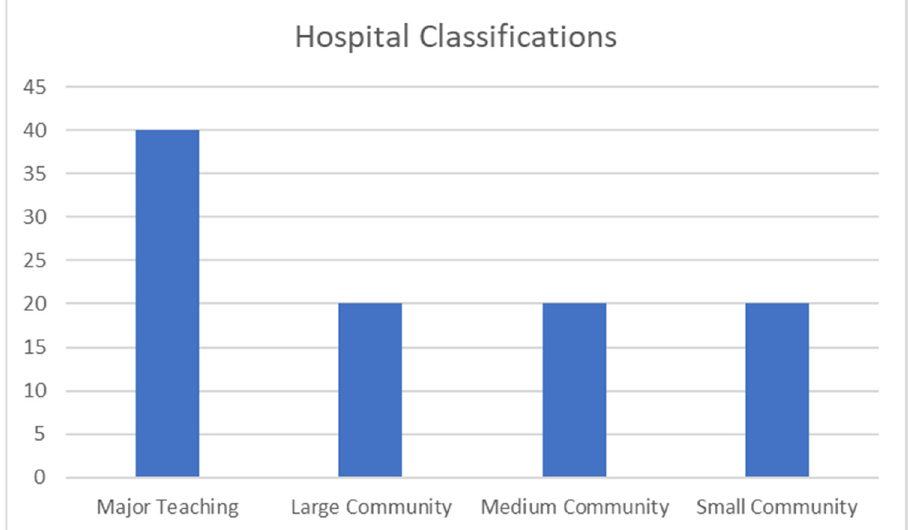
Figure 2. Breakdown of the top one hundred hospitals by